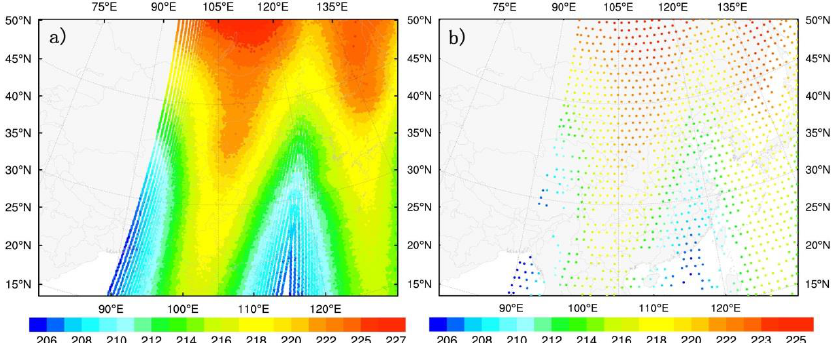
Figure 4. Distributions of brightness temperatures (K) calculated from ATMS radiances of channel 9 ( a ) before and ( b ) after quality control at 1800 UTC 18 July 2016, in the main domain of the